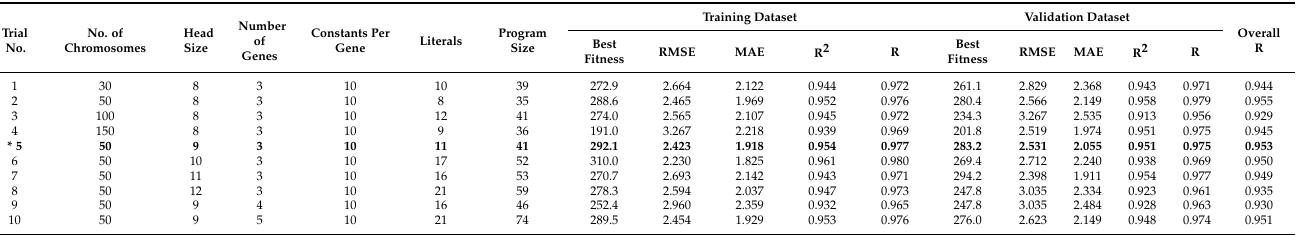
Table 5. Summary of undertaken trials using GEP for evaluating the CS 28d of waste PET/SCM blended cementitious grout.